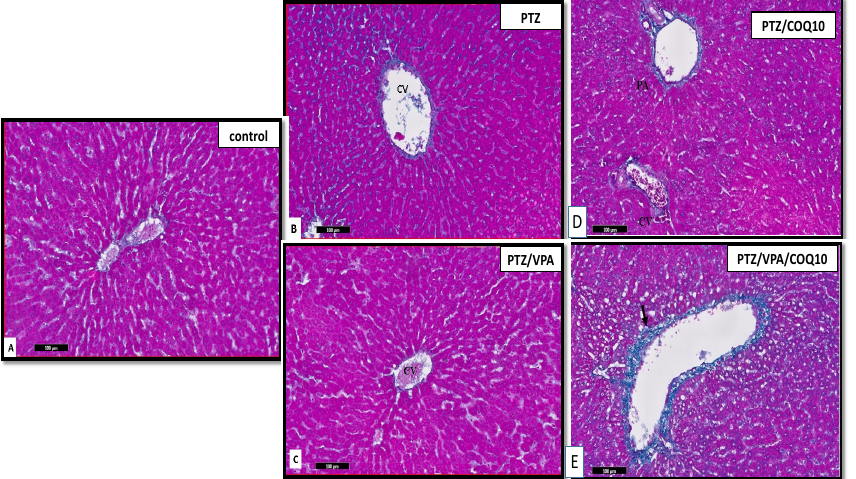
Figure 11. Photomicrographs of the stained liver sections (portal vein) of all of the rat groups. ( A ) Control group showing fine, blue ‐ stained fibers between the radially arranged hepatocytes around the central vein and around the portal area (P). ( B ) PTZ group showing condensed, green ‐ stained fibers between the radially arranged hepatocytes around the central vein (CV) and around the portal area (P). ( C ) PTZ/VPA group showing the apparent moderate increase in the green collagenous fibers. ( D ) PTZ/COQ10 showing the apparent decrease in the green, collagenous fibers around the central vein (CV) and portal areas (PV). ( E ) PTZ/VPA/COQ10 group showing fine, green, collagenous connective tissue between the cords of the hepatocytes, around the central vein and the walls of large vessels. ( → ). Masson trichrome stain/scale bar ( A – E 100 μ m).